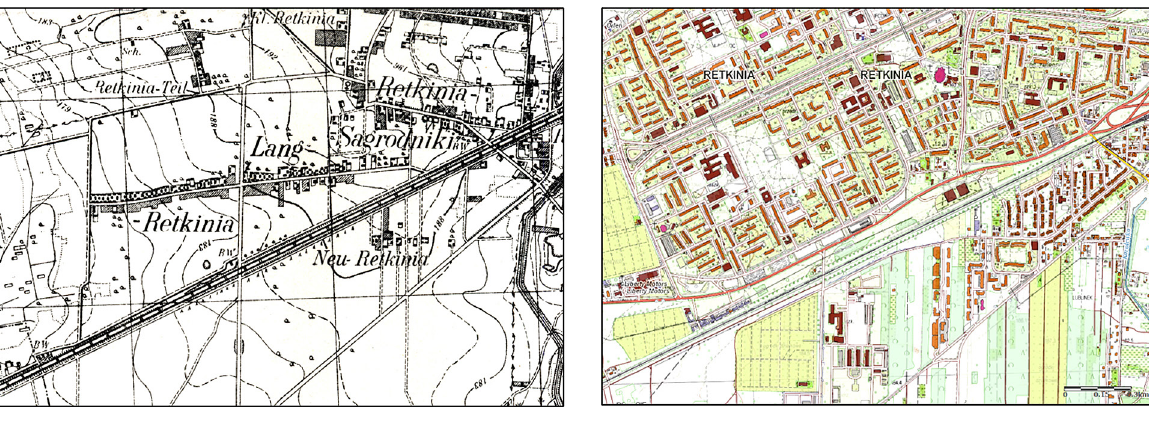
Fig. 7. Morphological changes in the former village of